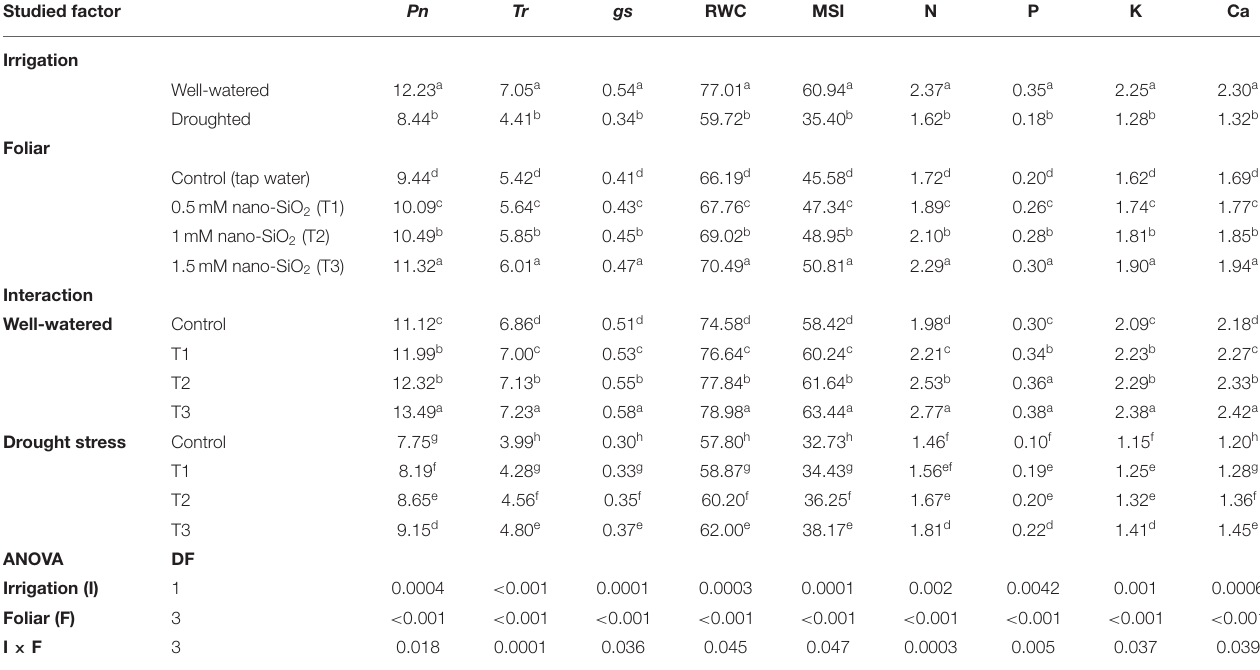
Studied factor Pn Tr Ca